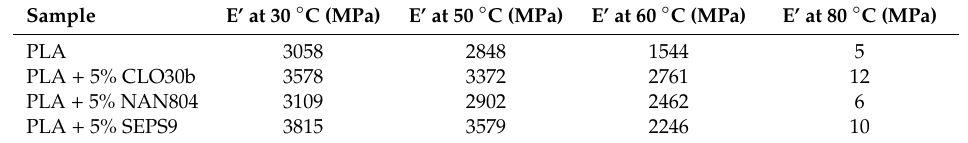
Figure 3. Storage modulus, E’, for ( a ) polylactic acid (PLA) and ( b ) PCL-based nanocomposite systems [37], Reproduced with permission from Fukushima K, Mater. Sci. Eng. C; published by Elsevier, 2009 . Table 1. E ′ value of nanocomposites of PLA at different temperature ranges. [37], Reproduced with permission from Fukushima K, Mater. Sci. Eng. C; published by Elsevier, 2009.